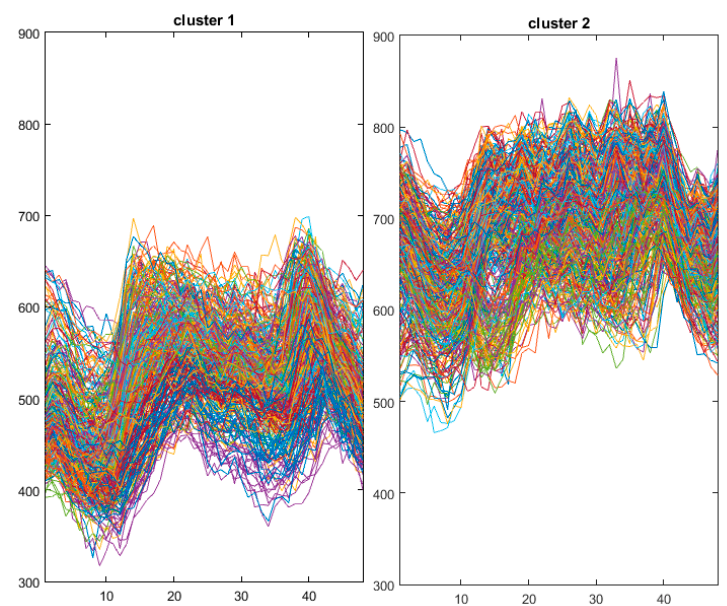
Figure 4. Clustering results (the left sub-figure includes low level load samples, the right sub-figure includes high level load samples).